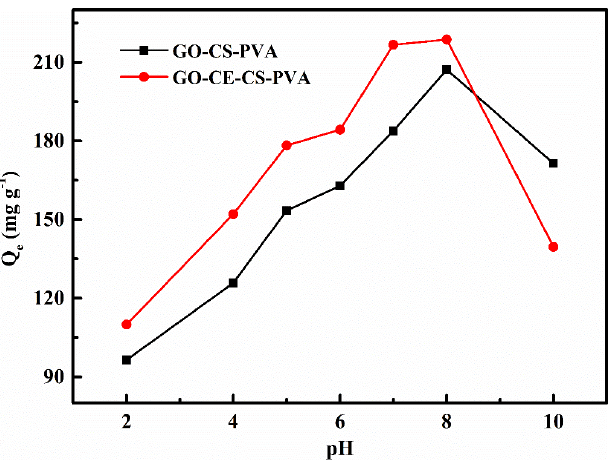
Figure 6. The effect of pH on the adsorption of Li + by GO − CE − CS − PVA and GO − CS −